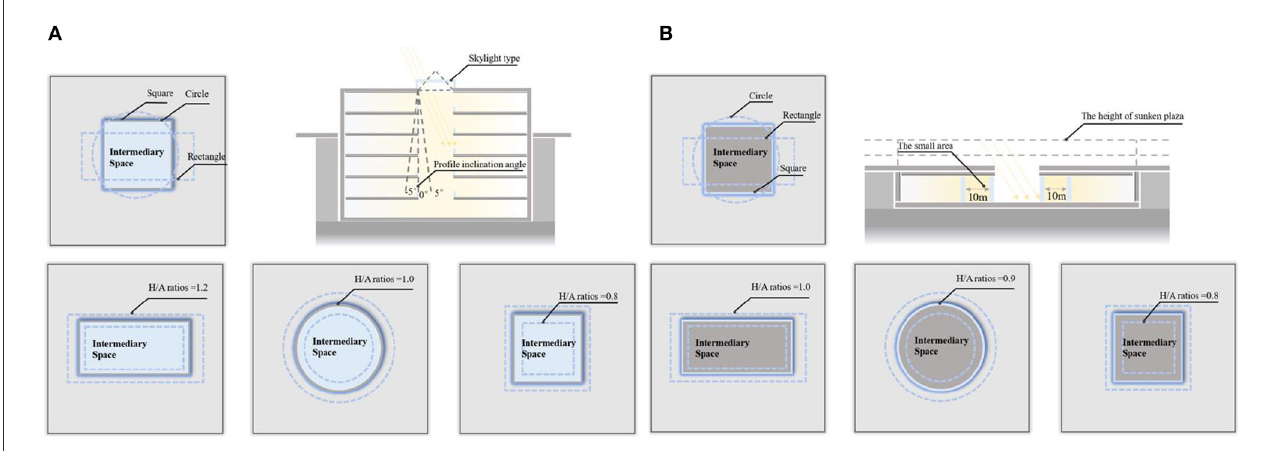
TABLE 2 The statistics of space size information form field research. Location Number of Shapingba